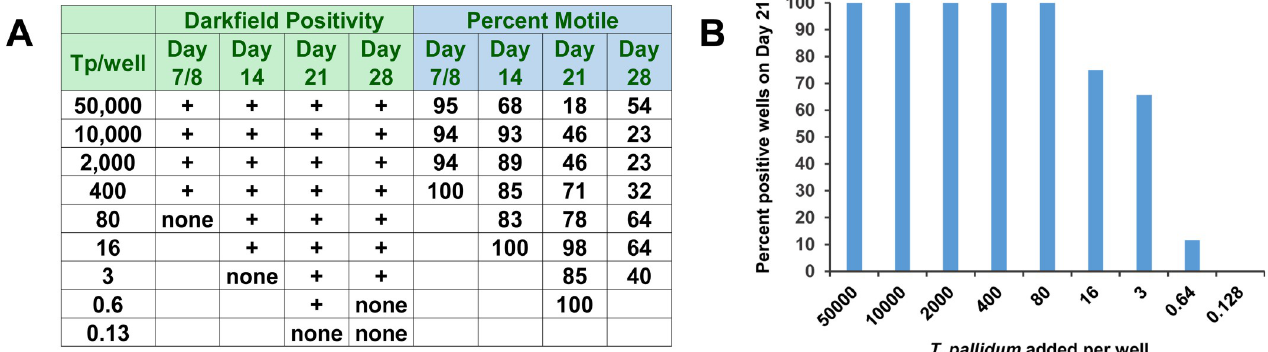
Fig 1. Culture of T . pallidum from low inocula. T . pallidum Nichols was inoculated at the indicated concentrations into 96-well plates in co-cultures with Sf1Ep cells and incubated in TpCM-2 under standard T . pallidum in vitro culture conditions. Half of the medium was replaced with fresh TpCM-2 weekly. (A) T . pallidum culture positivity and motility at each inoculum concentration, as determined by darkfield microscopy at each time point. (B) Percentage of wells positive for T . pallidum at 21 days post inoculation.